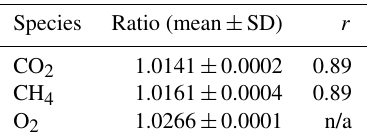
Table 4. Calculated biases of OP-NIR measurements relative to ei- ther in situ measurements or known mole fractions. “n/a” means not